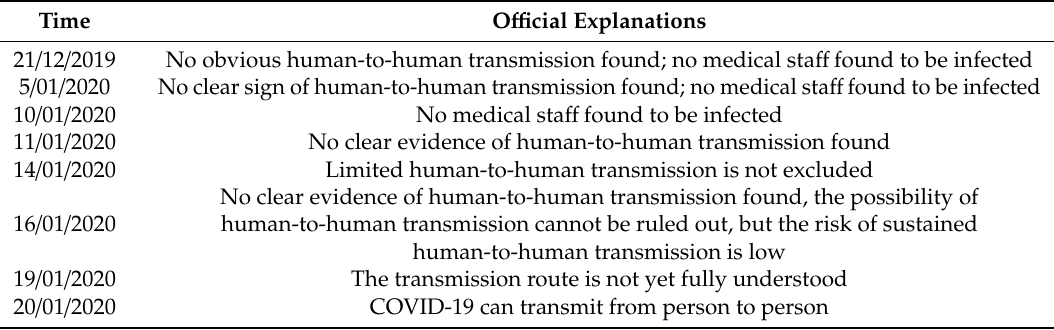
Table 1. The o ffi cial explanation by the national Center for Disease Control & Prevention (CDCP) about the transmission route of